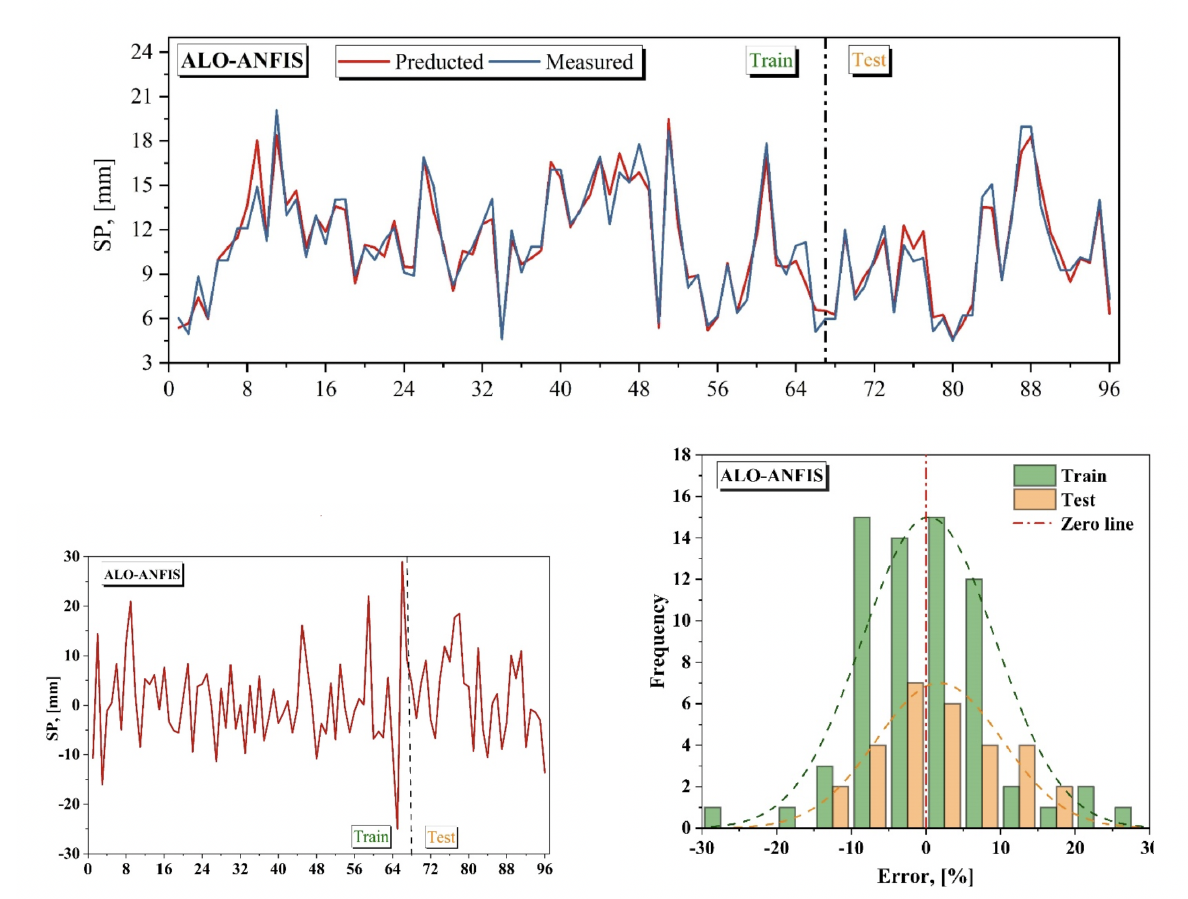
Fig. 12. Results of the introduced ALO-ANFIS model in predicting SP